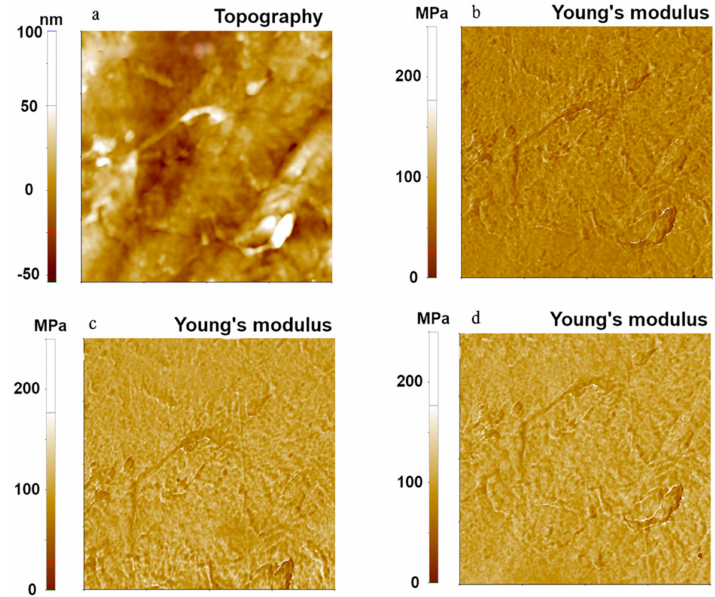
Figure 3. Topography ( a ) and Young’s modulus ( b – d ) images of LDPE using the PinPoint TM nanome- chanical mode. Young’s modulus images were obtained using Hertzian ( b ), DMT ( c ), and JKR ( d ) models. The scan size of all images was 10 µ m × 10 µ m.